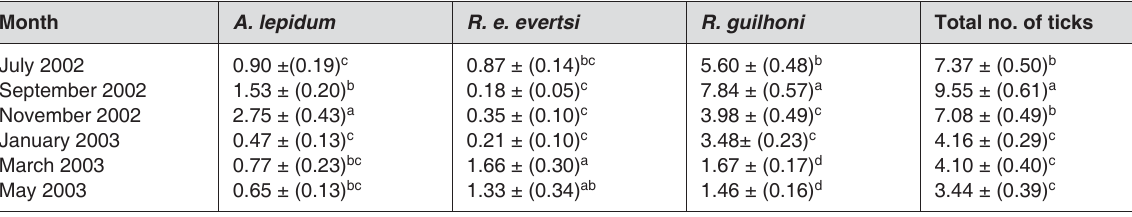
TABLE 2 Mean (± SE) numbers of ticks collected from sheep in Sennar State, Sudan in various months during 2002–2003 Month